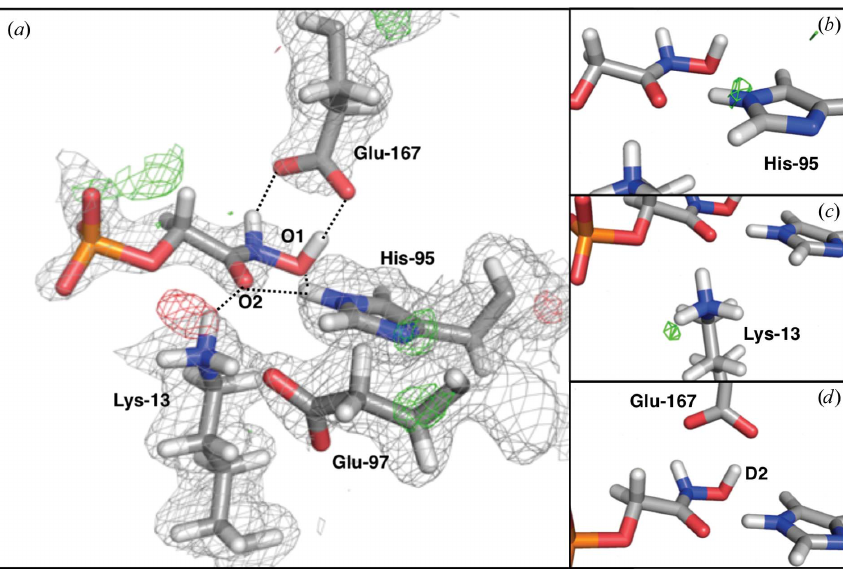
Figure 5 Joint X-ray/neutron-refined structure of PGH–TIM with the 2 mF o (cid:5) DF c nuclear scattering-length density map contoured at 1.0 (cid:2) and the mF o (cid:5) DF c nuclear scattering-length difference density maps contoured at 3.0 (cid:2) (green) and (cid:5) 3.0 (cid:2) (red). ( b – d ) Nuclear scattering-length OMIT maps at 3.0 (cid:2) of the D atoms of three important residues in the PGH–TIM active site: ( b ) His95, ( c ) Lys13 and ( d ) PGH (D2).